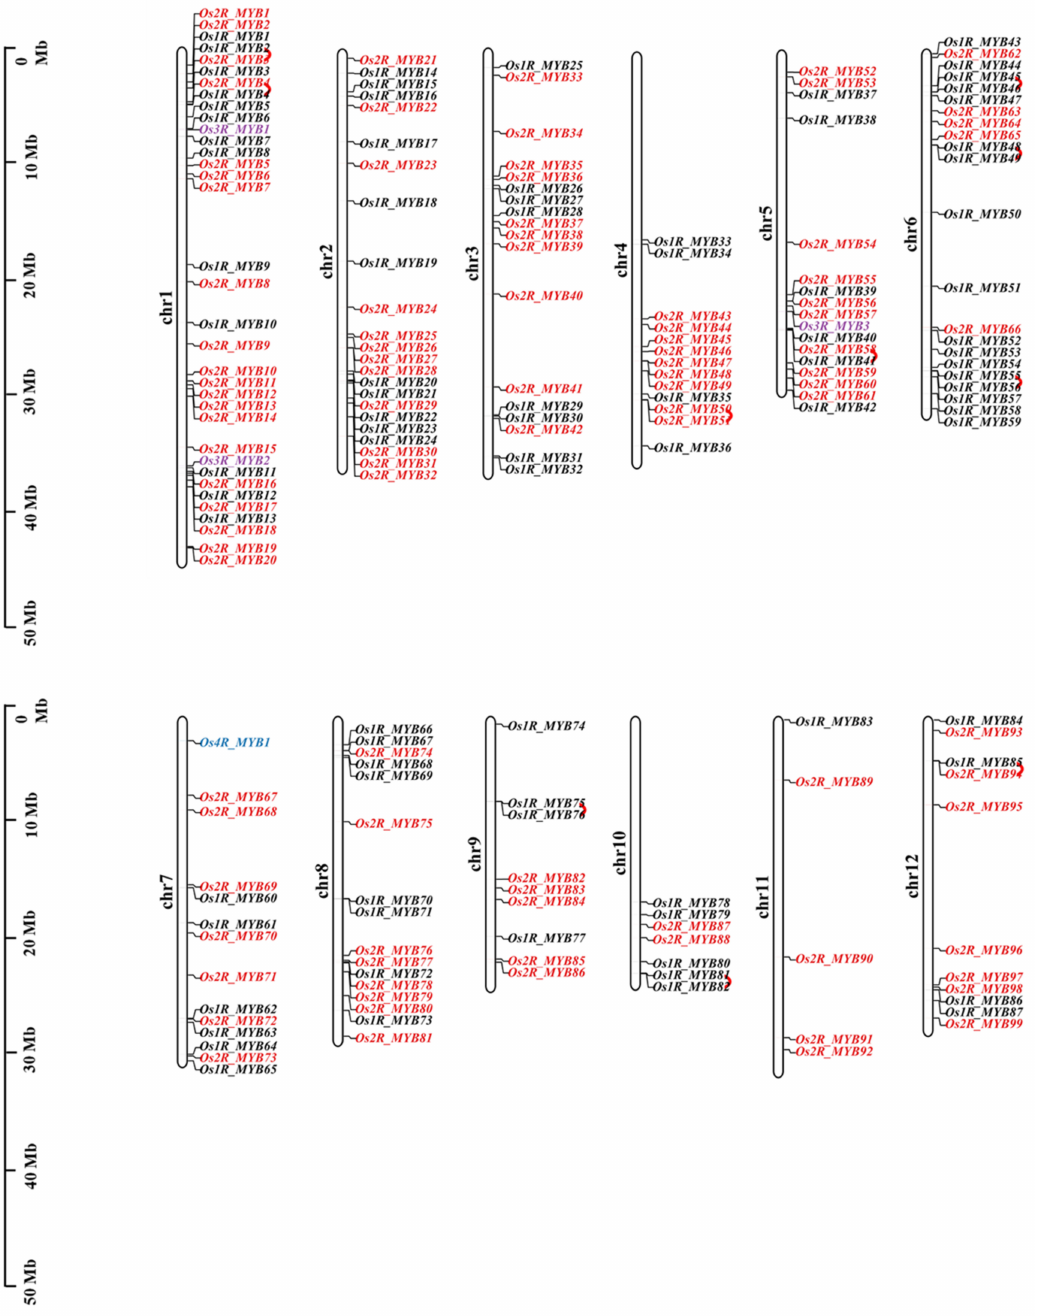
Figure 1. Distribution of OsMYBs on rice chromosomes. The rod represents the 12 chromosomes of rice, and the scale on the left indicates its length. Different colors represent the different MYB type: 1R_MYB (Black); 2R_MYB (Red); 3R_MYB (purple); 4R_MYB (blue). The repeat gene pairs were linked using red